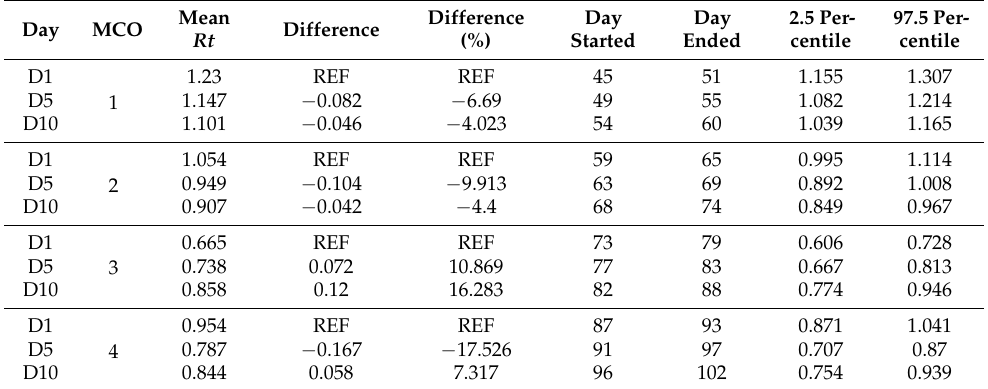
Table 2. Mean value of Rt at day 1, day 5 and day 10 for each MCO in Malaysia. Day MCO